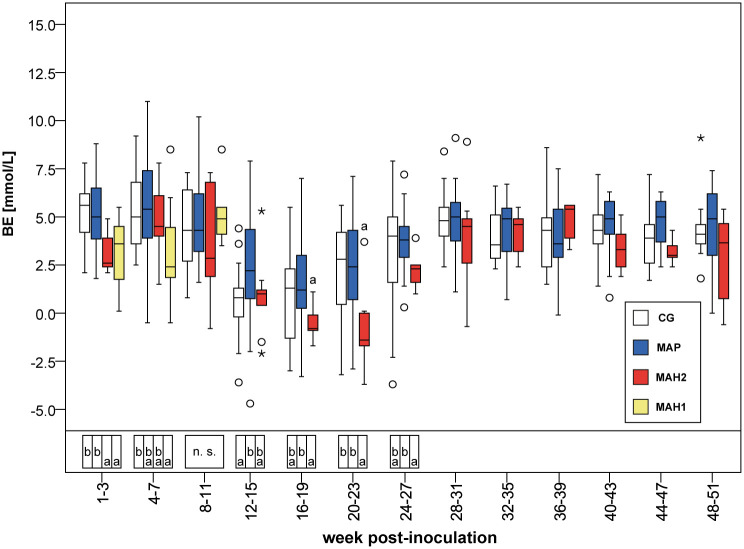
Calculated concentrations of base excess assessed in venous blood.CG, control group. MAP, group infected with Mycobacterium avium subsp. paratuberculosis. MAH 1, sub-group infected with Mycobacterium avium subsp. hominissuis with acute, severe form of infection. MAH 2, sub-group with chronic form of infection. Different letters indicate significant differences between groups within one period (Mann-Whitney U-test, P < 0.05). n.s., no significant differences between groups in the given period. From 28th week onwards Mann-Whitney U-test was not performed due to reduced numbers of observations. Significant differences within groups (Friedman test, P < 0.05) from 1st-3rd to 24th-27th wpi are given in S3–S5, and S10 Tables.